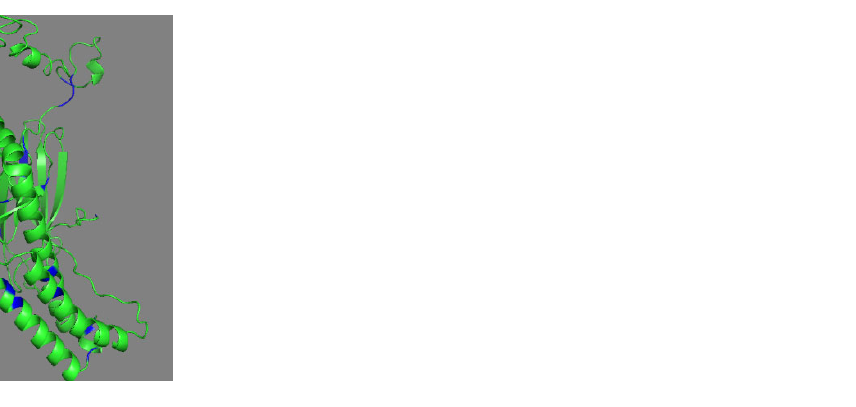
Figure 4. Swiss model generated LBP model based on template (PDB: 7KZI) with 50% of sequence Identity.